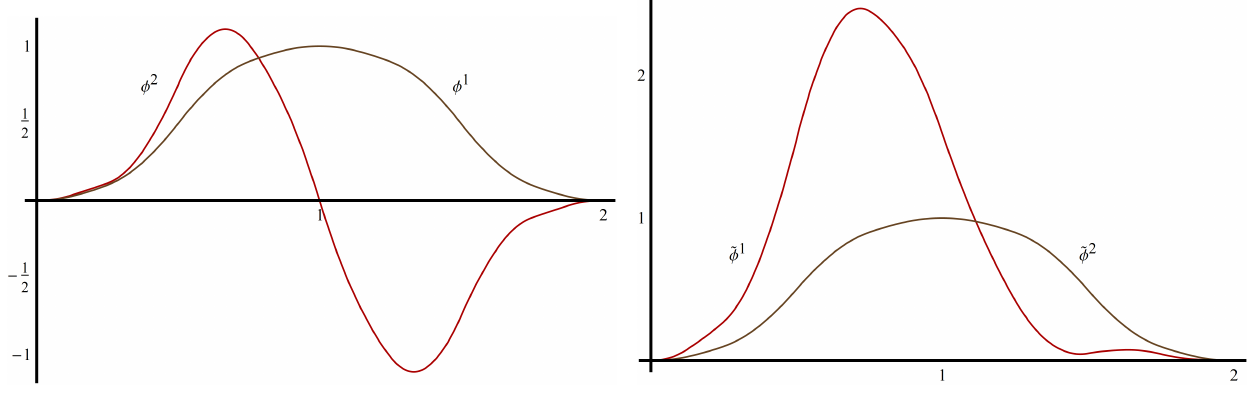
Figure 2. The scaling vector Φ (left) and the the new scaling vector ˜ Φ from Example 2.7